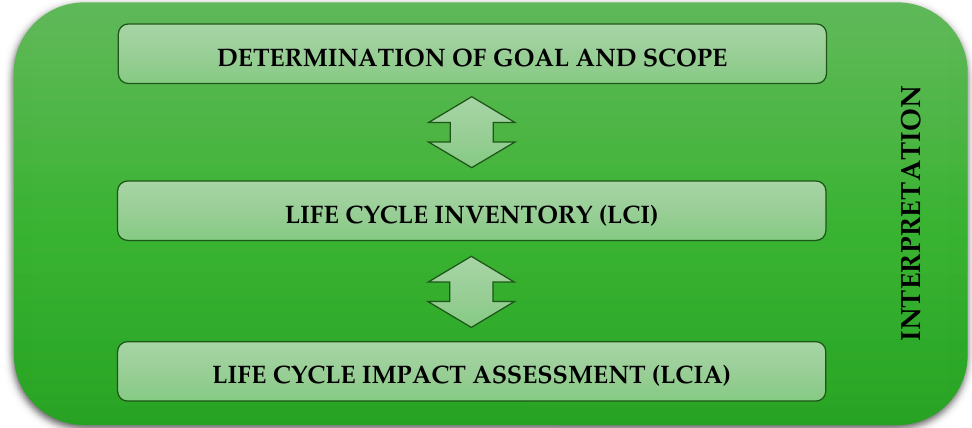
Figure 1. The stages of the LCA analysis (in accordance with the ISO 14040 and 14044 standards).